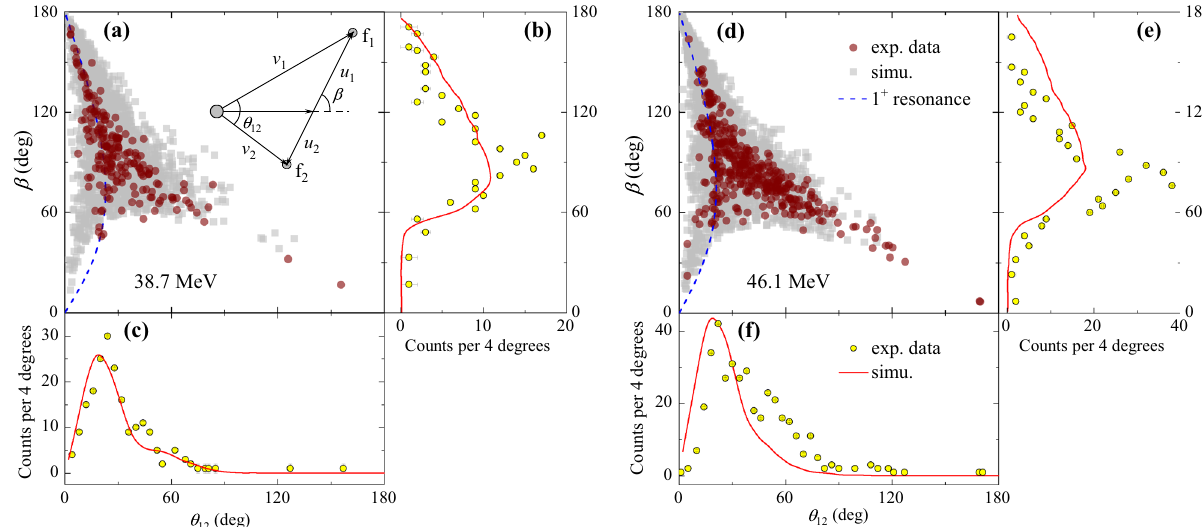
Fig.4|Angularcorrelationsofbreakupfragments 7 Beandproton. Comparison of experimental data (circles, with error bars indicating the associated statistical uncertainties) with simulations (squares) for correlations of β and θ 12 at a 38.7 and d 46.1 MeV. The dashed curves show the expected β - θ 12 correlation assuming asymptoticbreakup fromthe1 + resonanceof 8 B.Theprojectionsof β and θ 12 atthe